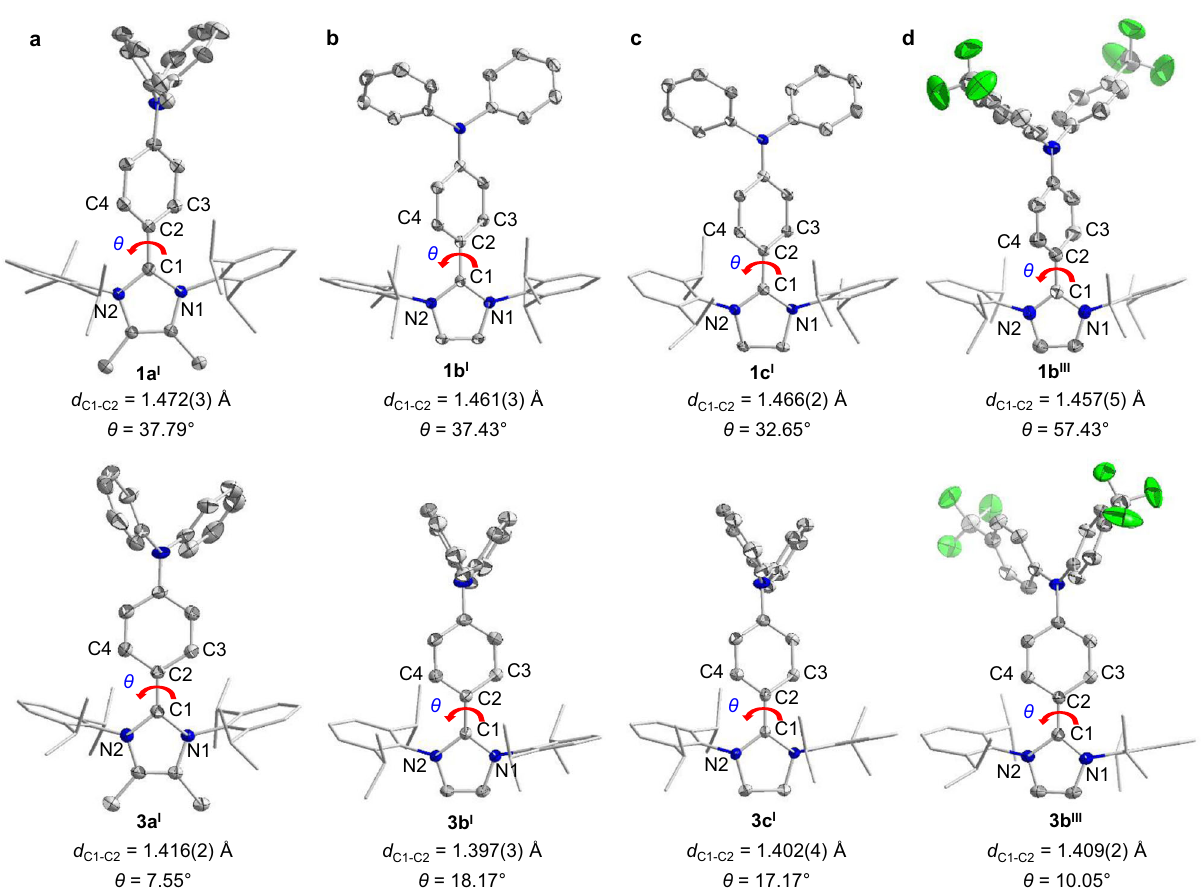
Fig. 2 | X-ray solid-state structures of the TPA – NHC precursors and their cor- respondingcarbon-centeredradicals.a X-raysolid-statestructuresforprecursor 1a I and radical 3a I . b X-ray solid-state structures for precursor 1b I and radical 3b I . c X-ray solid-state structures for precursor 1c I and radical 3c I . d X-ray solid-state structures for precursor 1b III and radical 3b III . θ : the twisted angle between the C3 – C2 – C4andN1 – C1 – N2plane.Thesinglecrystalsofradicalprecursors 1a I , 1b I , 1c I , and 1b III were grown by slowly diffusing diethyl ether into a saturated acetonitrile solutionatambienttemperature.Thesinglecrystalsofradicals 3a I , 3b I , 3c I ,and 3b III were obtained from a saturated hexane solution upon cooling to − 30°C.